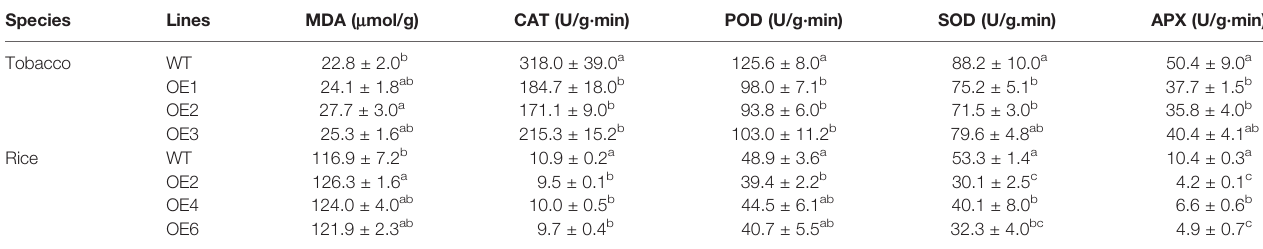
TABLE 3 | Measurement of antioxidant capacity of wild-type and ZmMYB59 transgenic plants Species